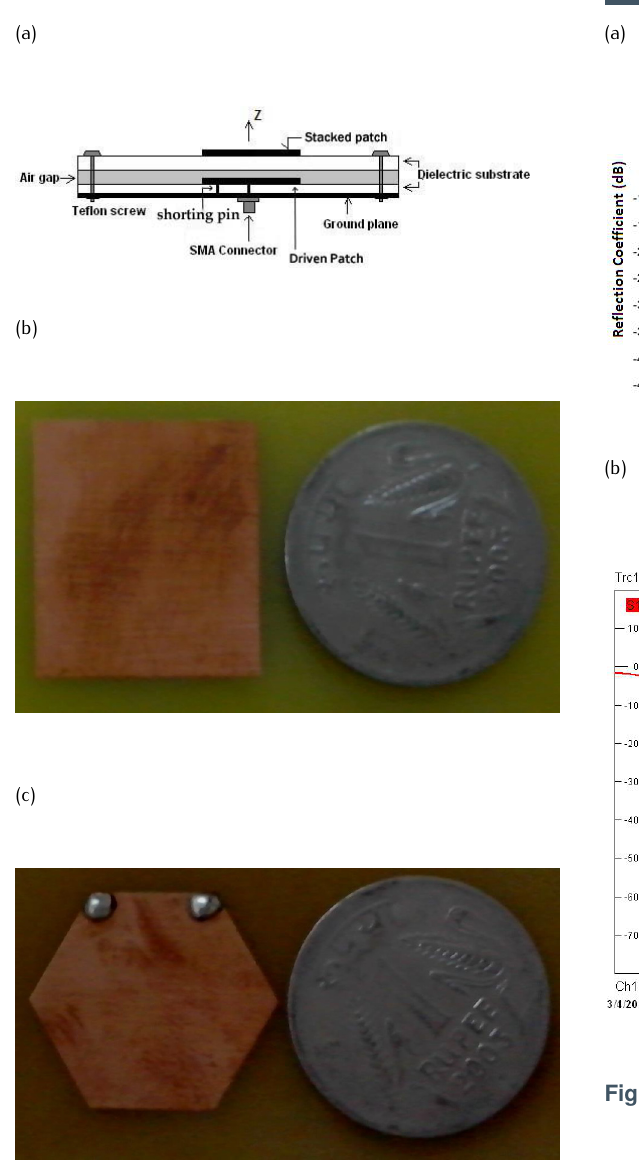
Figure 5. (a) Side view of stacked antenna structure with shorting pin. (b) Top view of designed rectangular patch. of two modes which are orthogonal to each other with (c)Top view of designed hexagonal patch with feed and equal amplitude and phase quadrature are desired. The shorting pin. possible presence of two orthogonal patch modes or for confirmation of circular polarization condition, axial ratio of antenna with frequency is simulated as shown in Figure 8. It is observed that the axial ratio presented by antenna within frequency range 4.311 to 4.384 GHz (73 MHz) is well within prescribed 3 dB range. The minimum value of axial ratio is 0.088 dB at frequency 4.352 GHz which indicates pure circular polarization at this frequency. For analyzing the type of polarization, simulated E-plane right and left circularly polarized